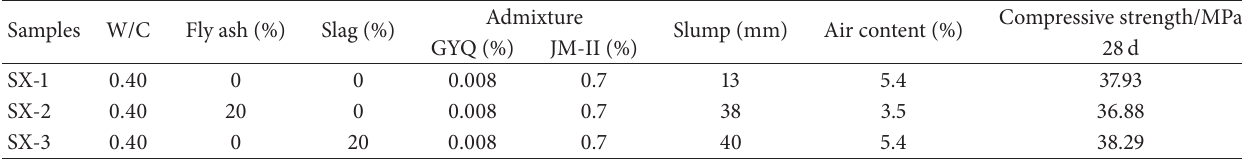
Table 2: Mix proportions of concrete.